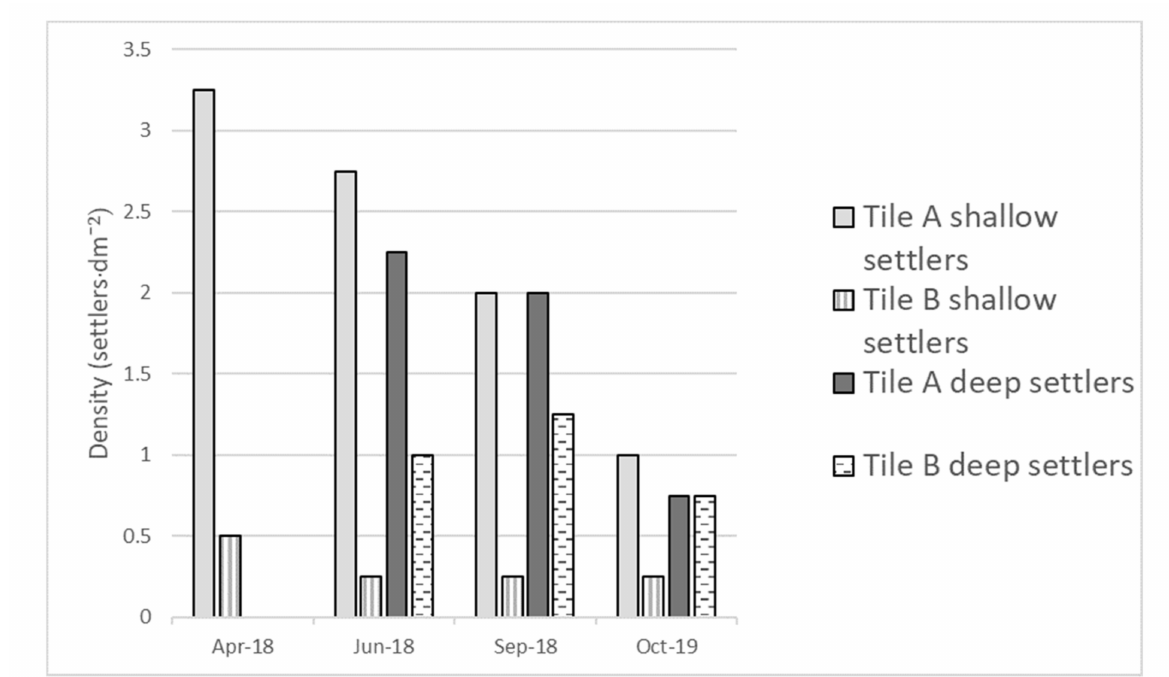
Figure 9. Settlement density (expressed in settlers · dm − 2 ) of C. rubrum shallow and deep settlers from the beginning of the experiment in deep water to October 2019 on each tile at Portofino